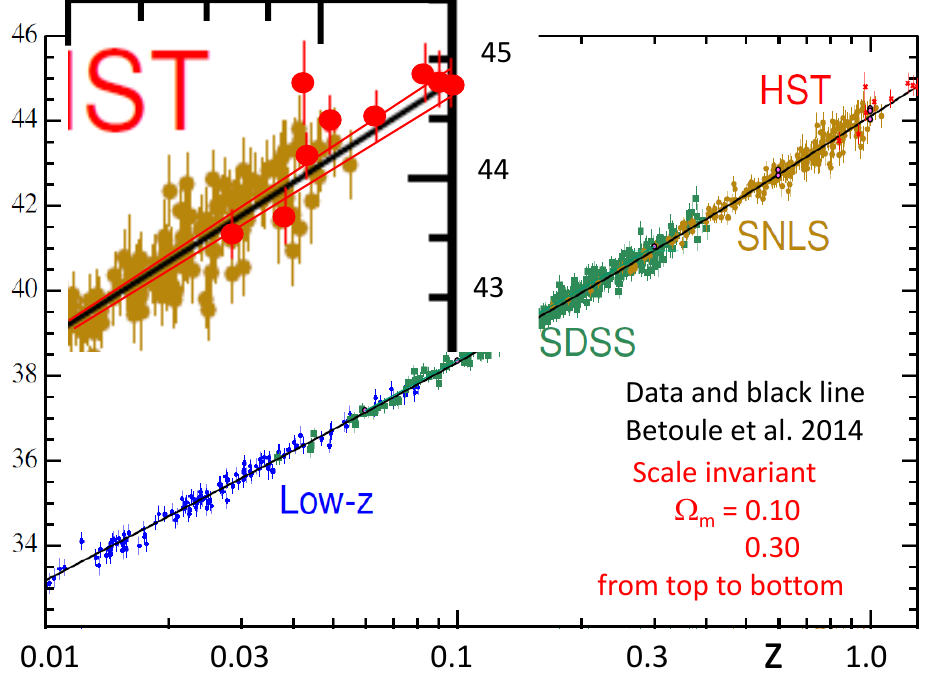
Figure 5. The magnitude-redshift diagram by Betoule et al. [19] based on the joint analysis of SNIa observations in the SDSS-II and SNLS collaborations. The upper right corner of the plot is enlarged in an insert. The scale invariant models with Ω m = 0.10 and 0.30 are indicated by red lines. The black line is the best fit Λ CDM model for Ω m =